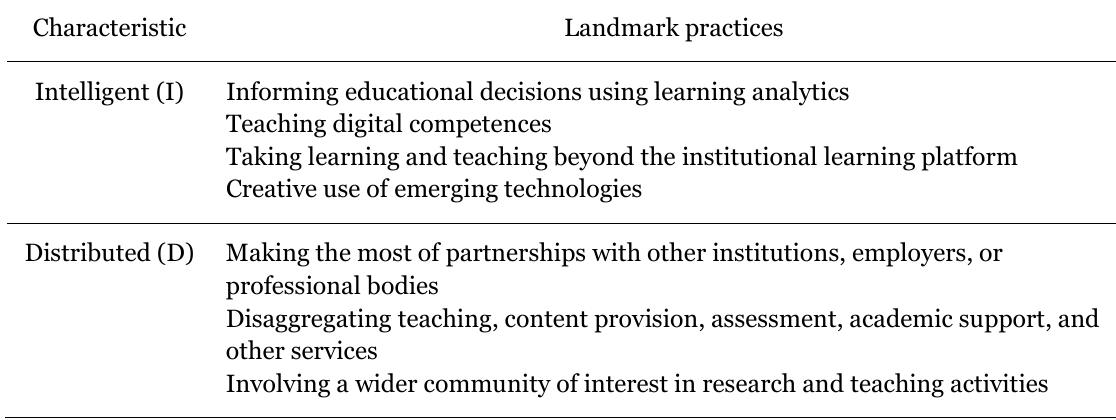
IDEAS Next-Generation Pedagogy Framework for Transforming Higher Education Characteristic Landmark